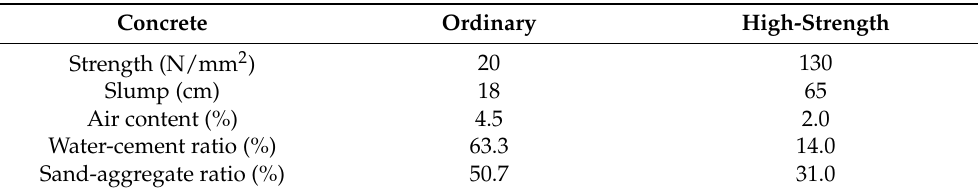
Table 1. Mix proportion.